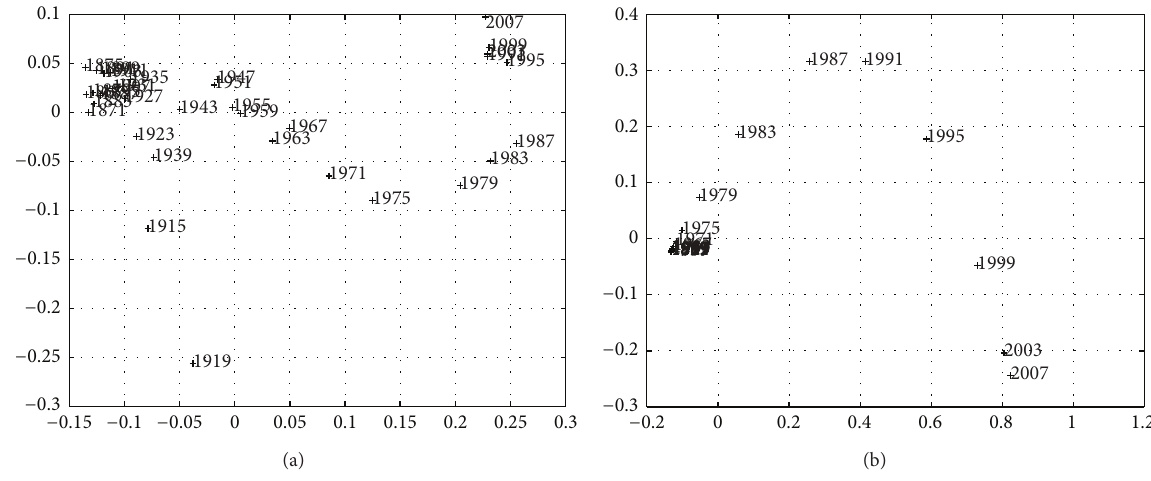
Figure 10: Two-dimensional MDS maps of the Portuguese economic evolution: 𝑇 = 1867 – 2010 , ℎ = 4 years for 𝑟 𝐶 (a) and 𝑟 𝐸 (b).